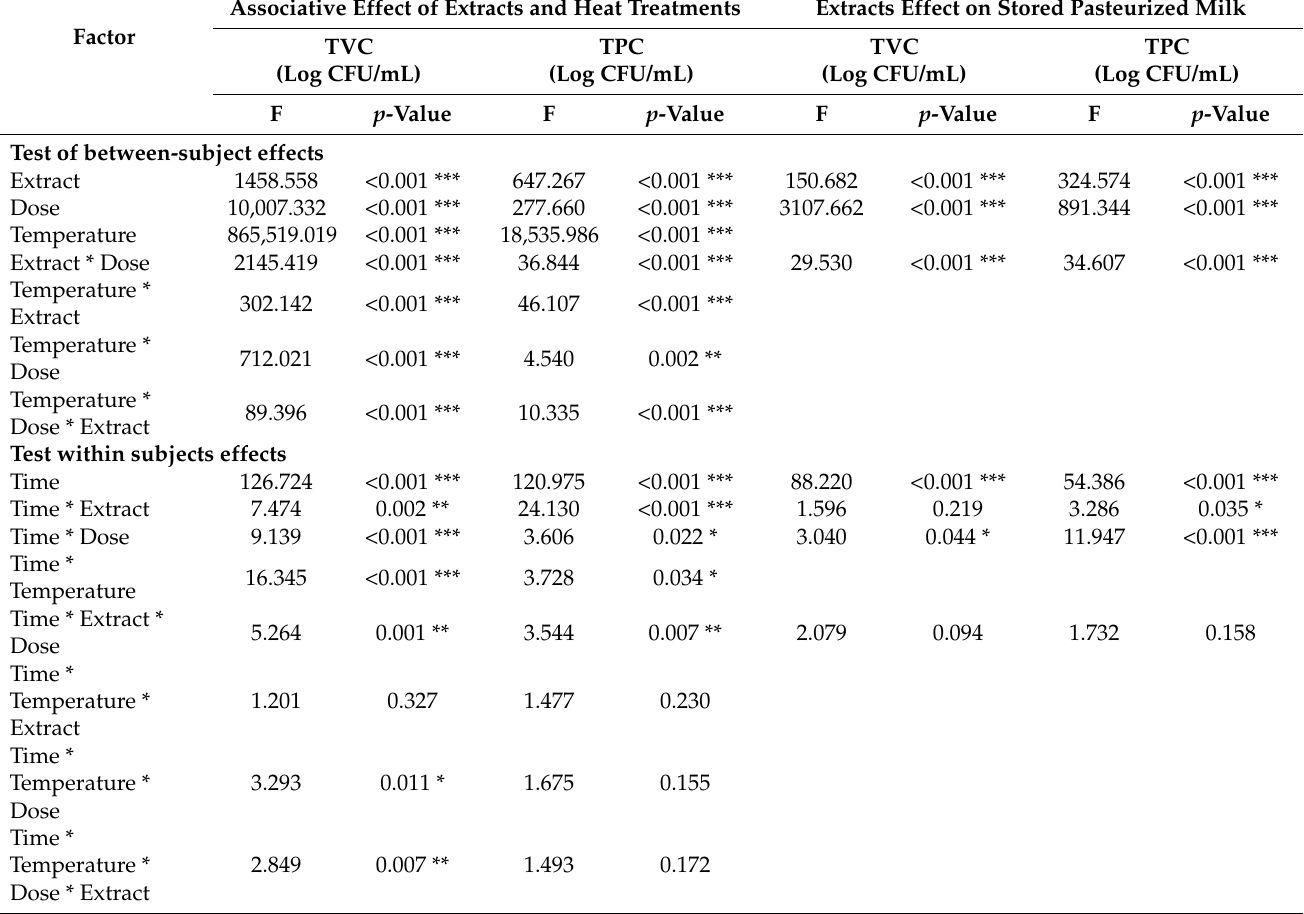
Table 3. Results of General Lineal Model (GLM) repeated measures by means of one-way